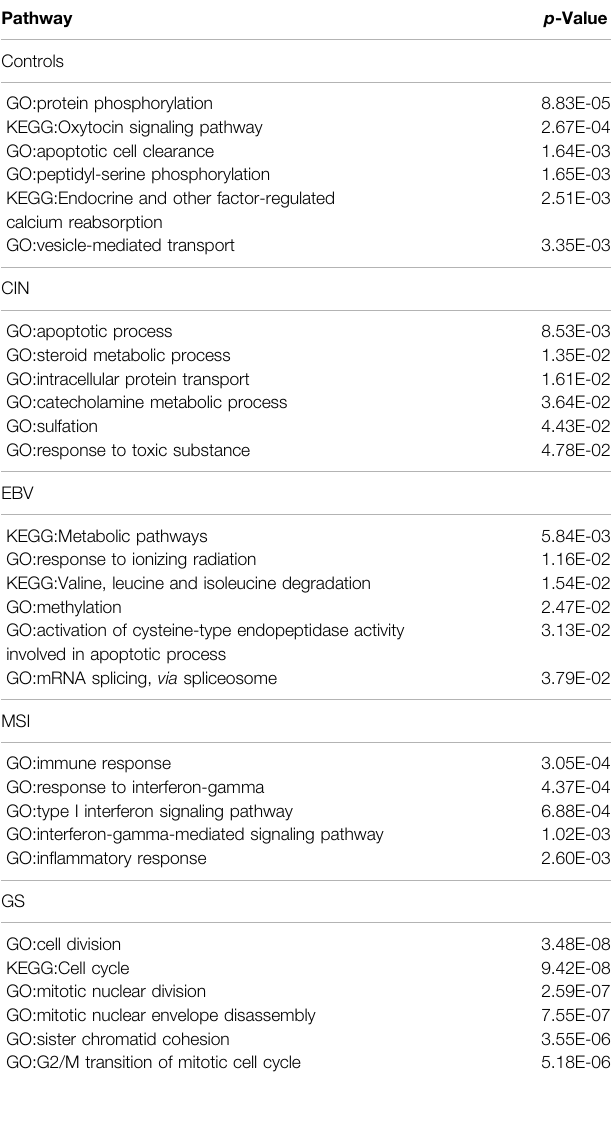
TABLE3| Themostsigni fi cantlyenrichedpathwaysbythegenesbelongingtotop 200 speci fi c edges of each molecular subtype in